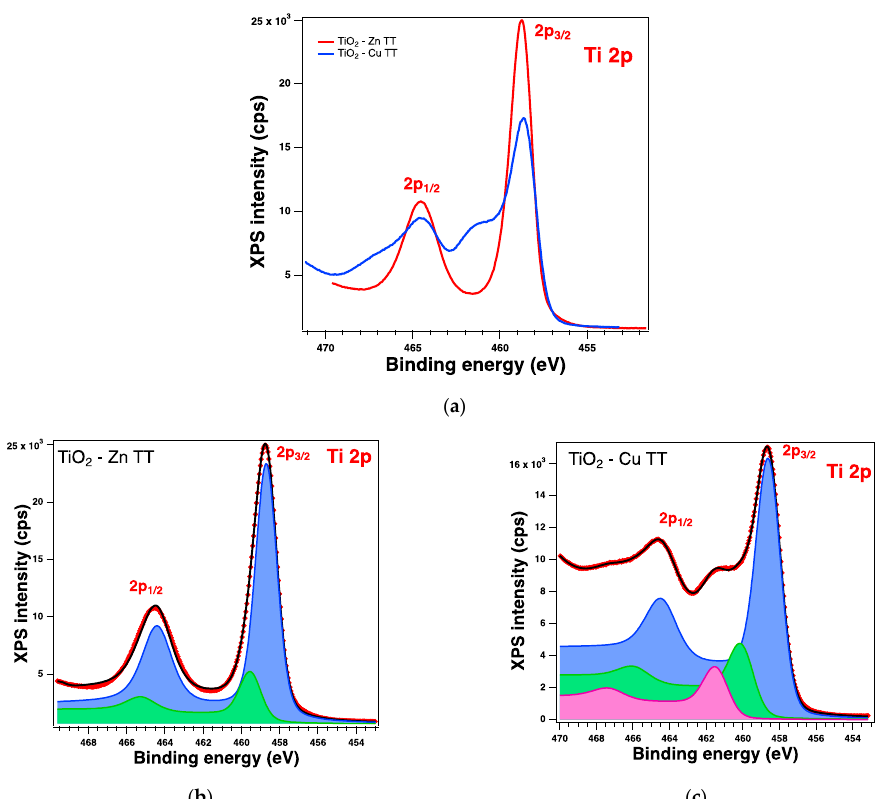
Figure 13. XPS spectra of the Ti 2p level for treated samples: ( a ) comparison of experimental data: red line for the Zn-doped samples and blue line for the Cu-doped samples, and ( b , c ) the fit and deconvolutions for the Zn and the Cu samples, respectively: red symbols for the experimental data overlayed with a black line, blue line for C1, green line for C2, and magenta line for C3 (for ( c )